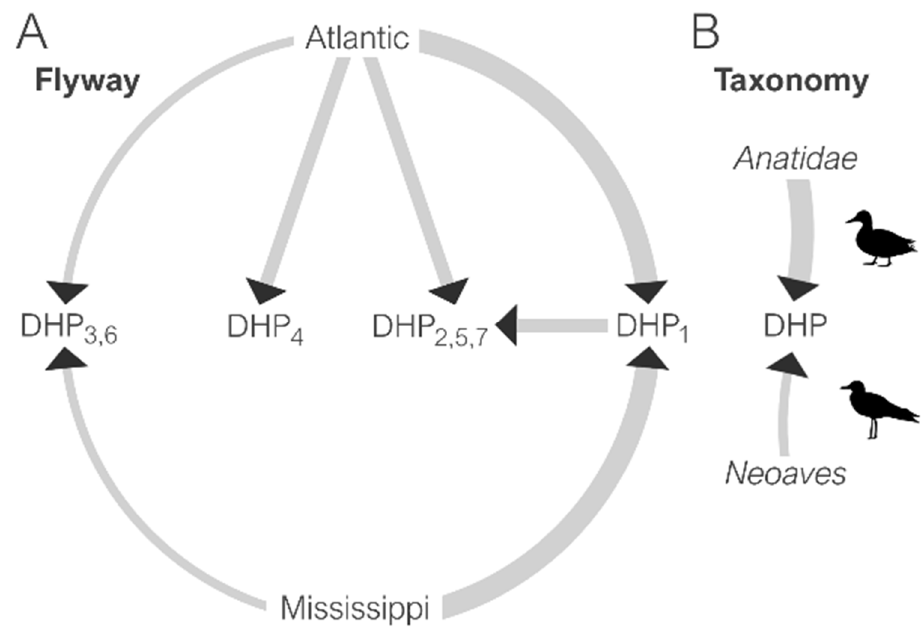
Figure 5. Dissemination of IAVs among flyways, taxonomic groups and duck hunting preserves. The magnitude of viral gene flow, quantified by Markov jumps (available in Supplementary Tables S2–S6), is proportional to the width of the arrow between USA flyways ( A ) and avian taxonomic group ( B ). Specifically, the arrow width represents the relative proportion of viruses seeded into a given DHP from various sources, inferred across phylogenies for all segments (thin arrow— low proportion of viral introductions attributed to this source; thick arrow—high proportion of viral introductions attributed to this source).